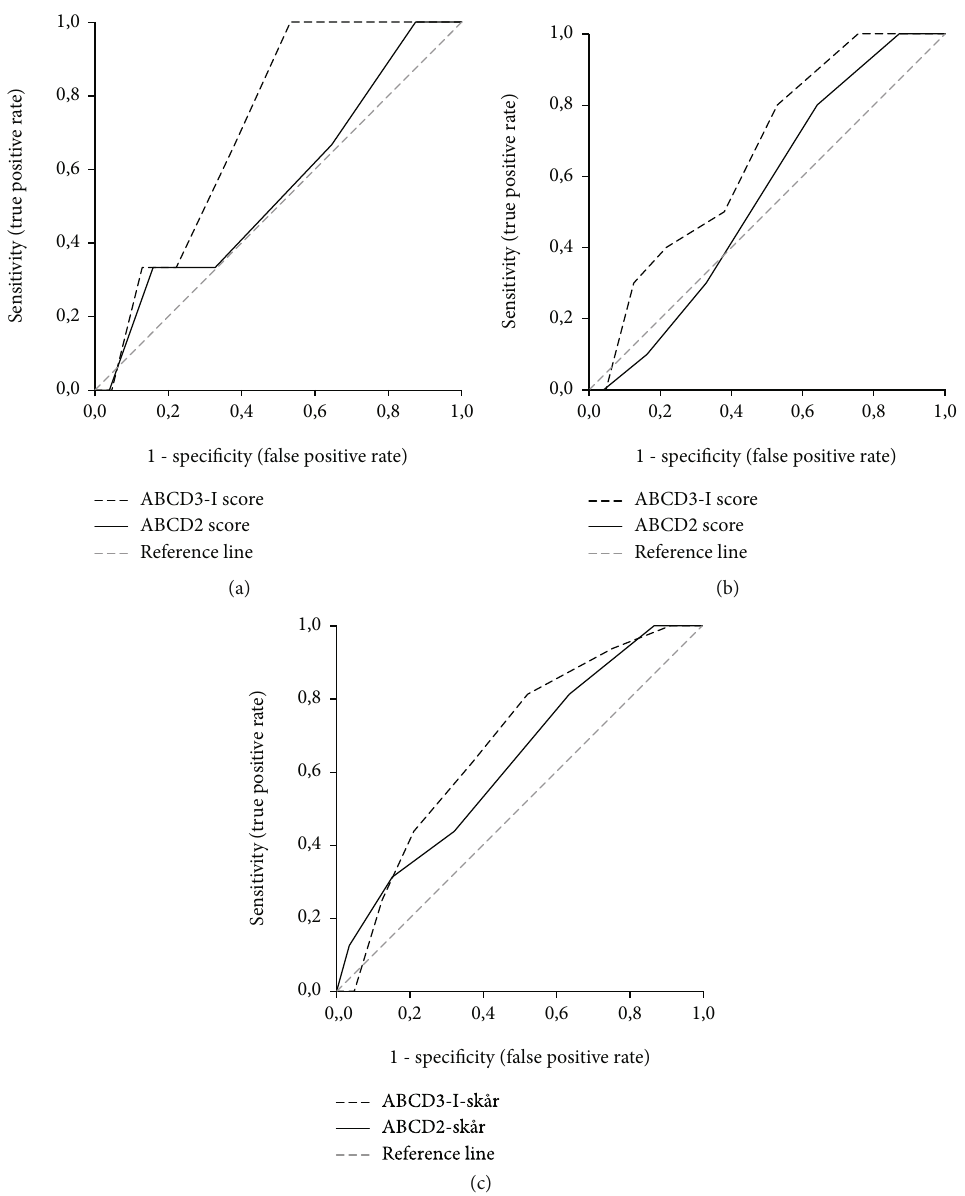
Figure 2: ROC curves of the ABCD3-I score and ABCD2 score at 1 week (a), 3 months (b), and 1 year